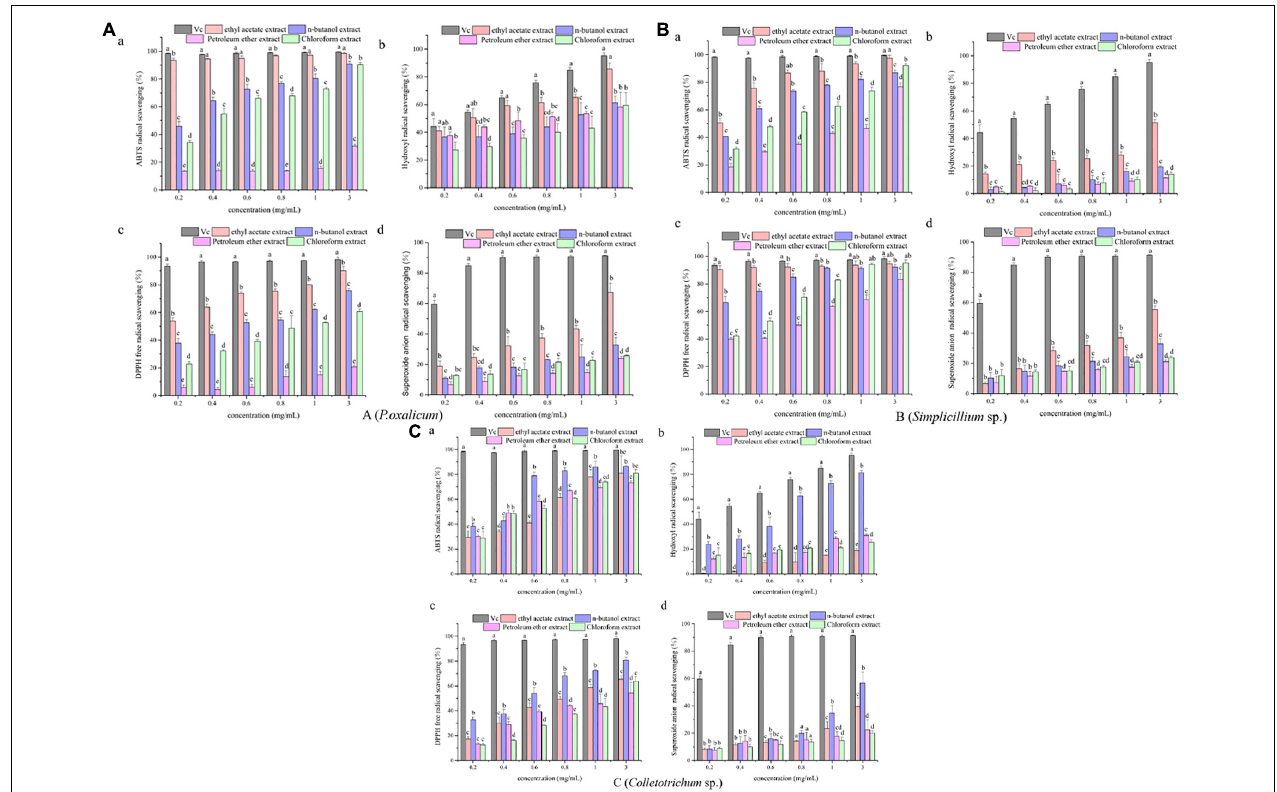
FIGURE 2 | Antioxidant activities of the P. oxalicum (A) , Simplicillium sp. (B) , and Colletotrichum sp. (C) extracts. a: ABTS scavenging activity. b: Hydroxyl radical scavenging activity. c: DPPH radical scavenging activity. d: Superoxide anion radical scavenging activity. a–d: Significant differences between different groups ( p <